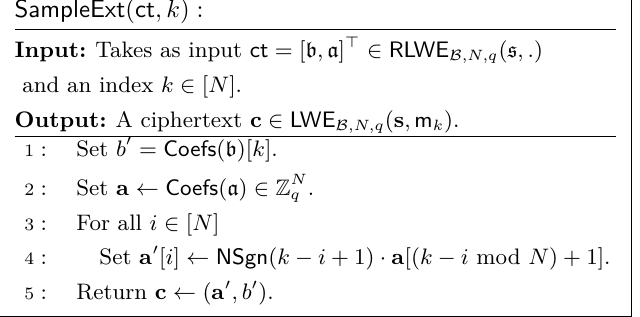
Figure 7: Sample and key extraction. The KeyExt ( s ) function on input key s ∈ R N,q outputs its coefficient vector. That is it outputs Coefs ( s ).